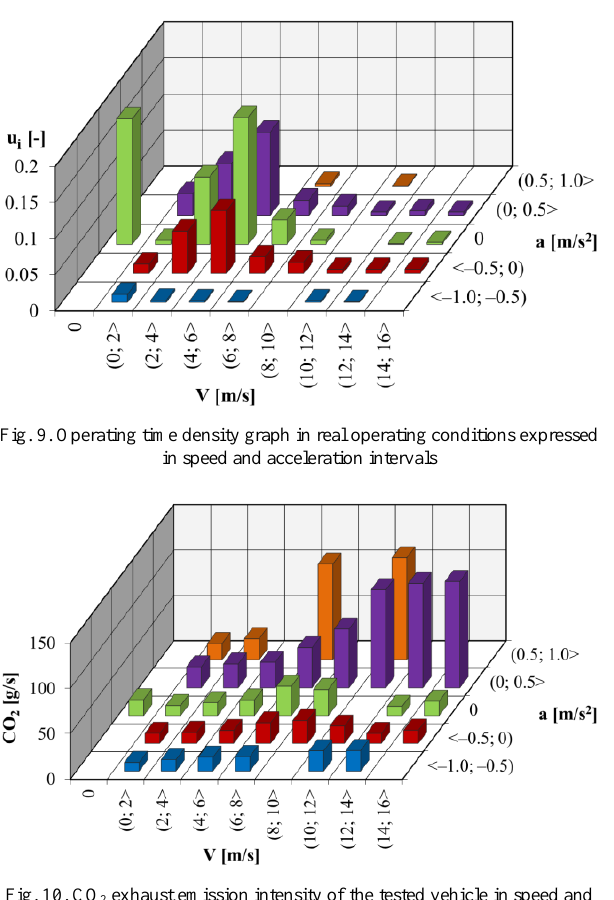
Fig. 10. CO 2 exhaust emission intensity of the tested vehicle in speed and acceleration intervals